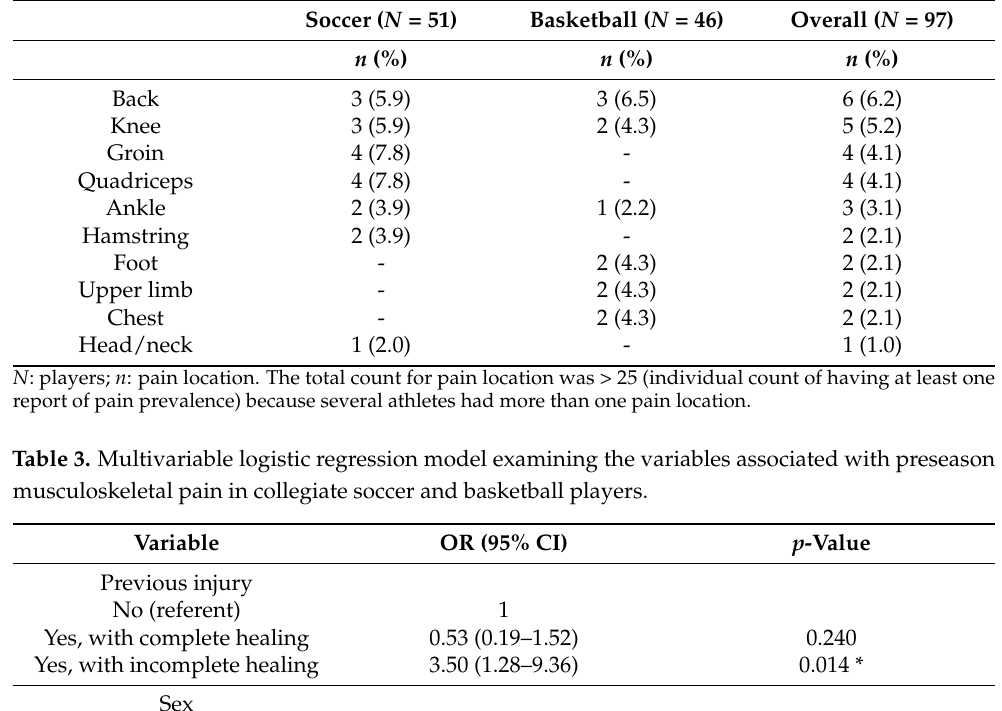
Table 2. Location of musculoskeletal pain in collegiate soccer and basketball players.